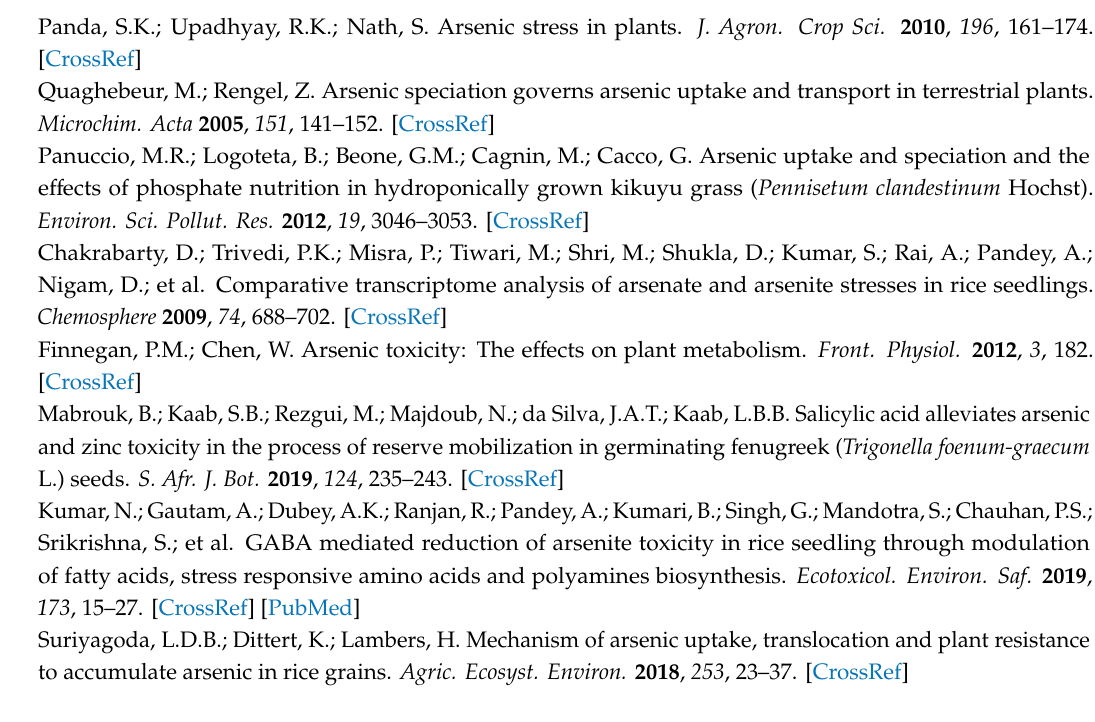
Figure S1: E ff ects of arsenic on stomatal conductance in two contrasting tobacco genotypes, Figure S2: E ff ects of arsenic on proline contents in two contrasting tobacco genotypes, Figure S3: E ff ects of arsenic on total glutathione contents in two contrasting tobacco